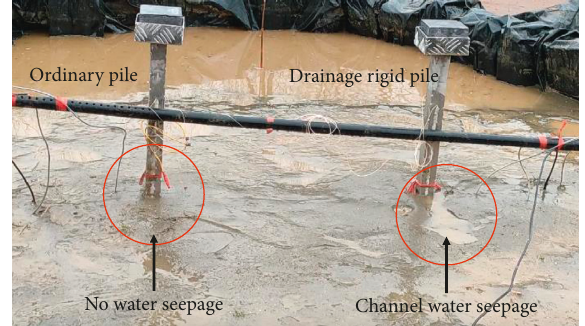
Figure 9: Schematic diagram of gushing water in the drainage